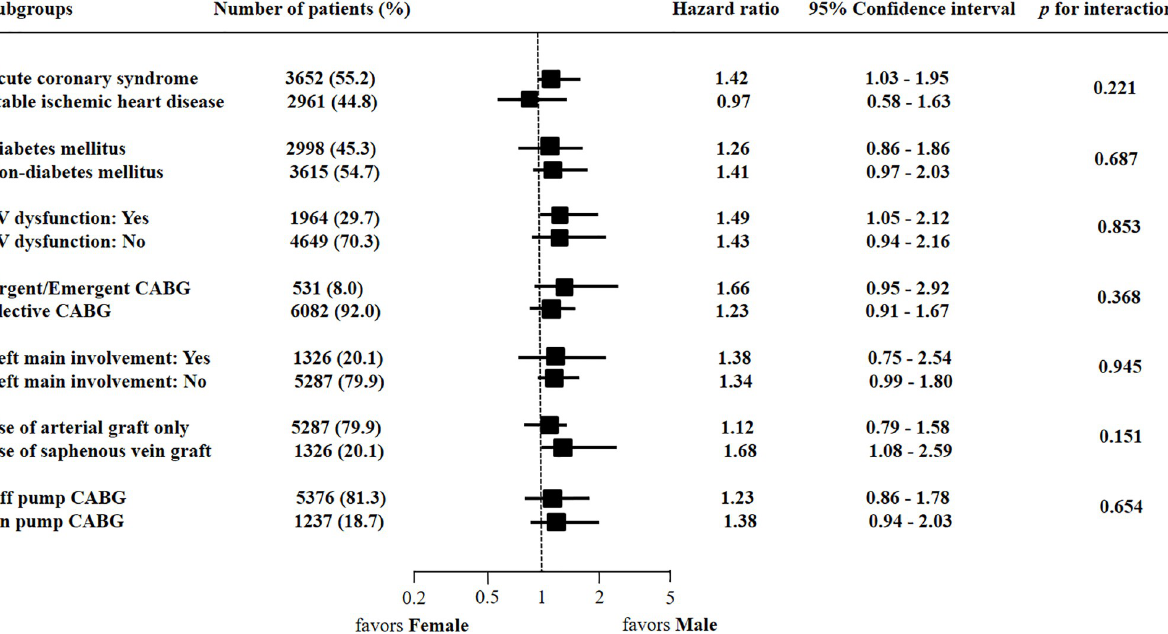
PLOS ONE | https://doi.org/10.1371/journal.pone.0279030 March 2,